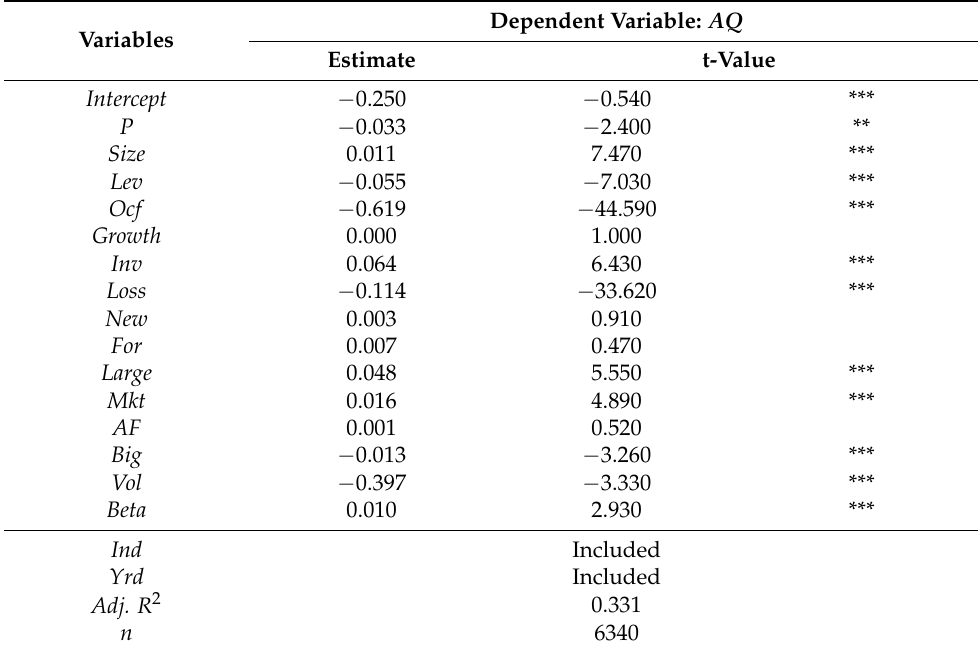
Table 6. Relationship between partner’s audit hour ratio and audit quality. Dependent Variable: AQ Variables Estimate t-Value Intercept −